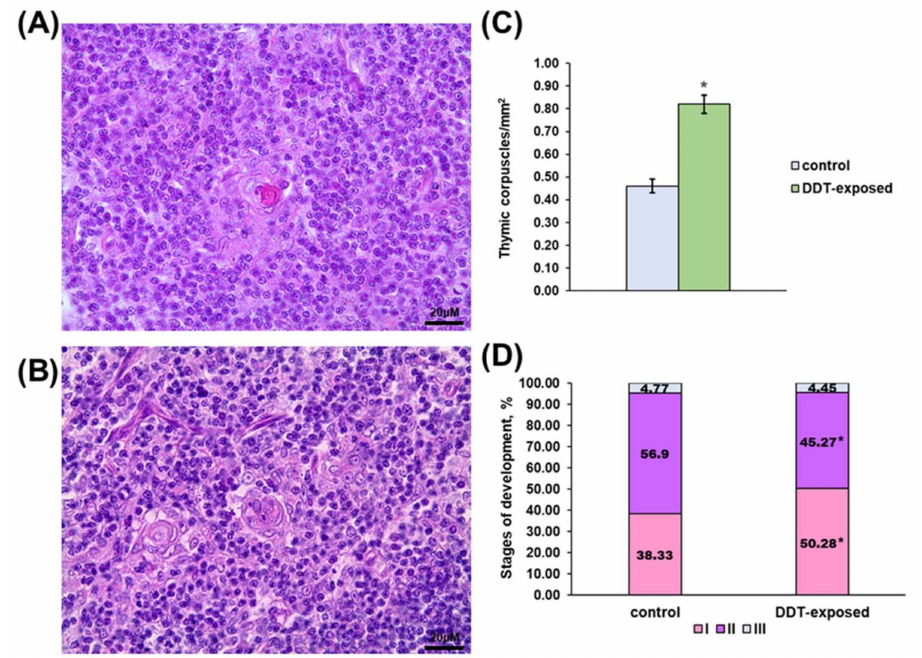
Figure 2. Characterization of thymic corpuscles in prenatally and postnatally exposed to DDT and intact adult rats aged 10 weeks. Structure of thymic corpuscles in the control ( A ) and DDT-exposed ( B ) rats. Magnification 400. Number of thymic corpuscles in 1 µ m 2 of the medulla ( C ). Data presents as mean ± S.E.M. Stages of thymic corpuscles development ( D ). p < 0.05 compared to the control